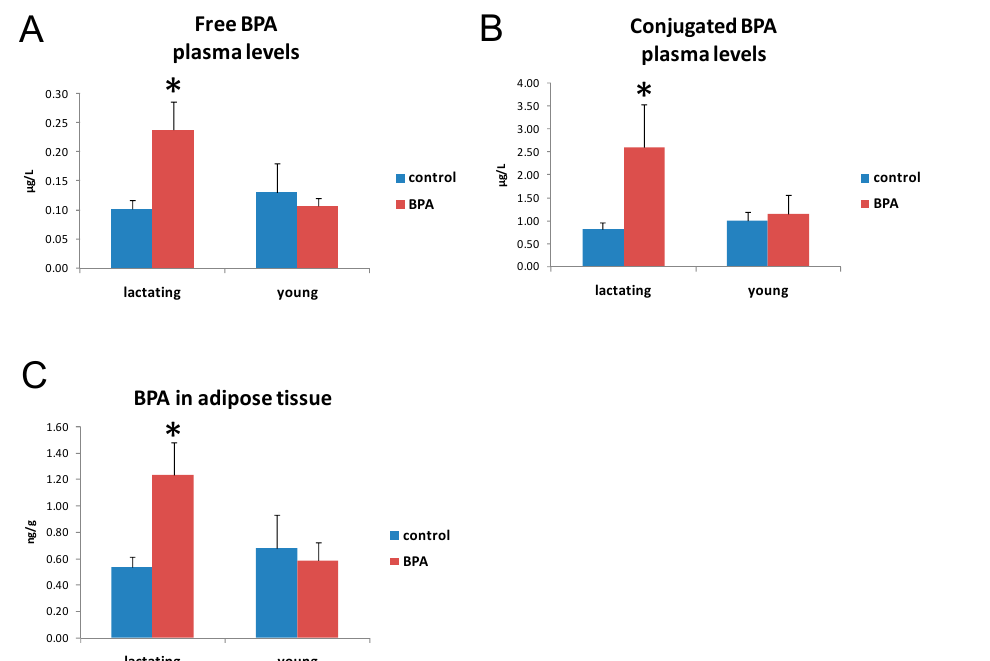
Figure 1. Free-BPA plasma levels in lactating and young rats drinking BPA-added (BPA) or tap water (control) ( A ). Conjugated-BPA plasma levels in lactating and young rats drinking BPA-added (BPA) or tap water (control) ( B ). BPA levels in adipose tissue from lactating and young rats drinking BPA-added (BPA) or tap water (control) ( C ). Data are reported as mean and SE. * p < 0.05 compared to all other groups.